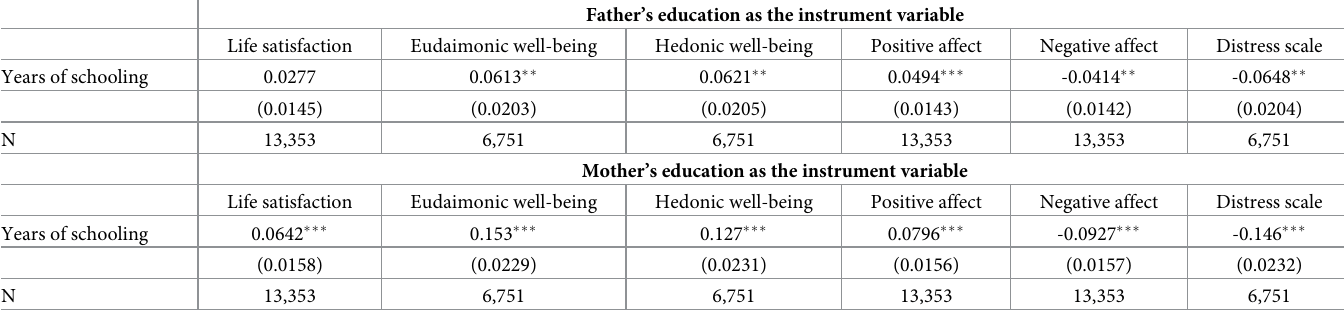
Table 5. Robustness check—alternative